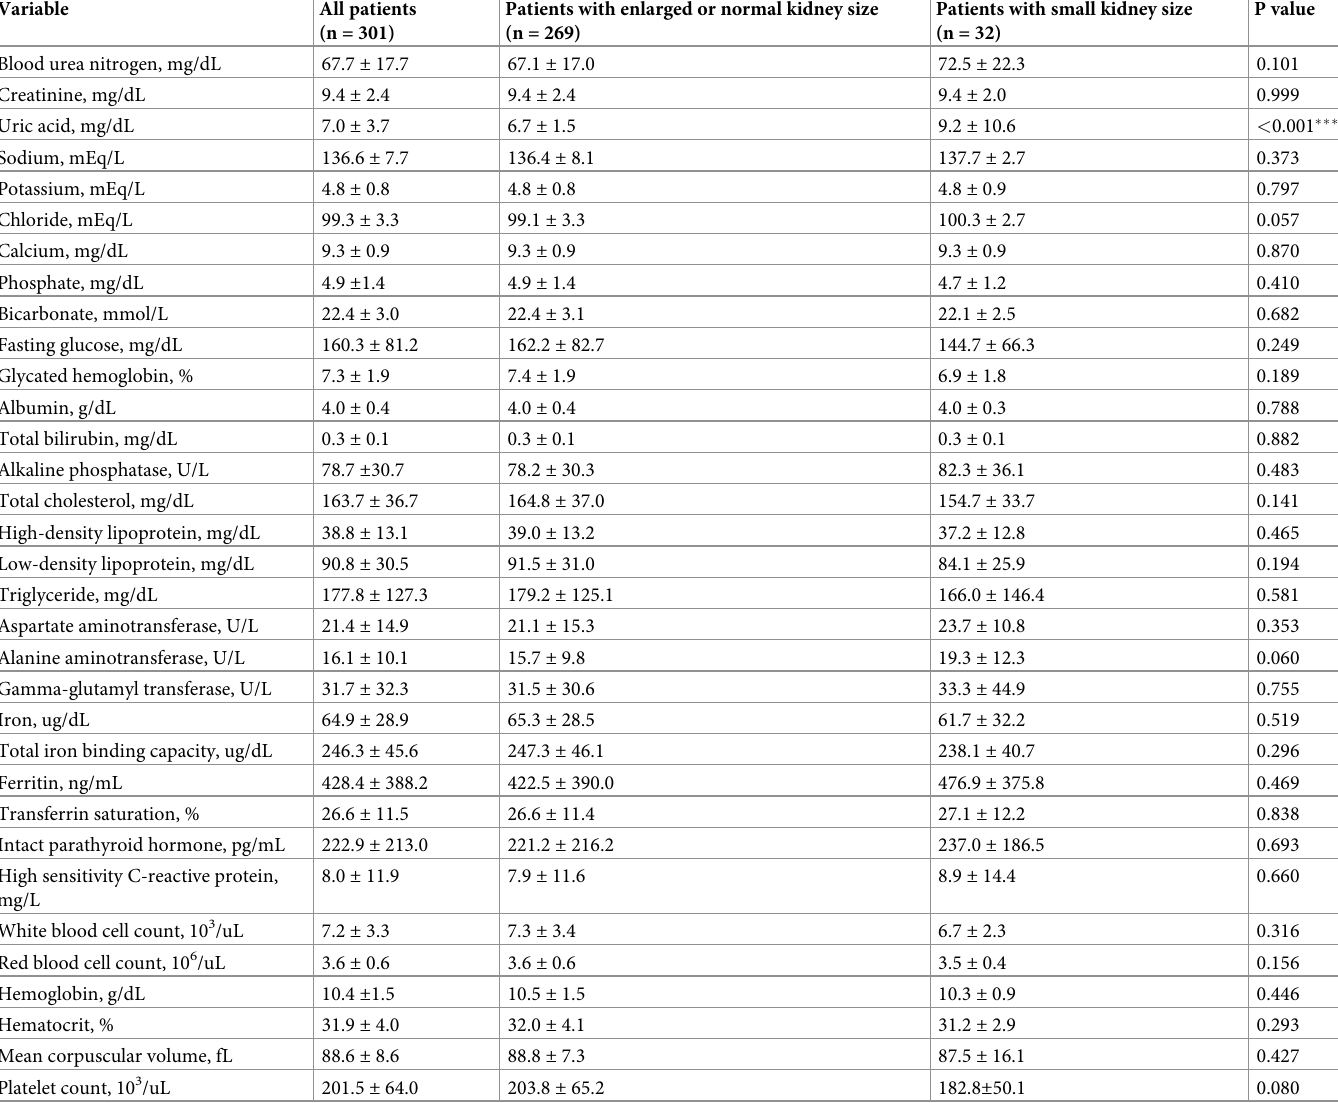
Table 2. Laboratory data of diabetic patients receiving hemodialysis stratified by kidney size (n = 301). Variable All patients (n =